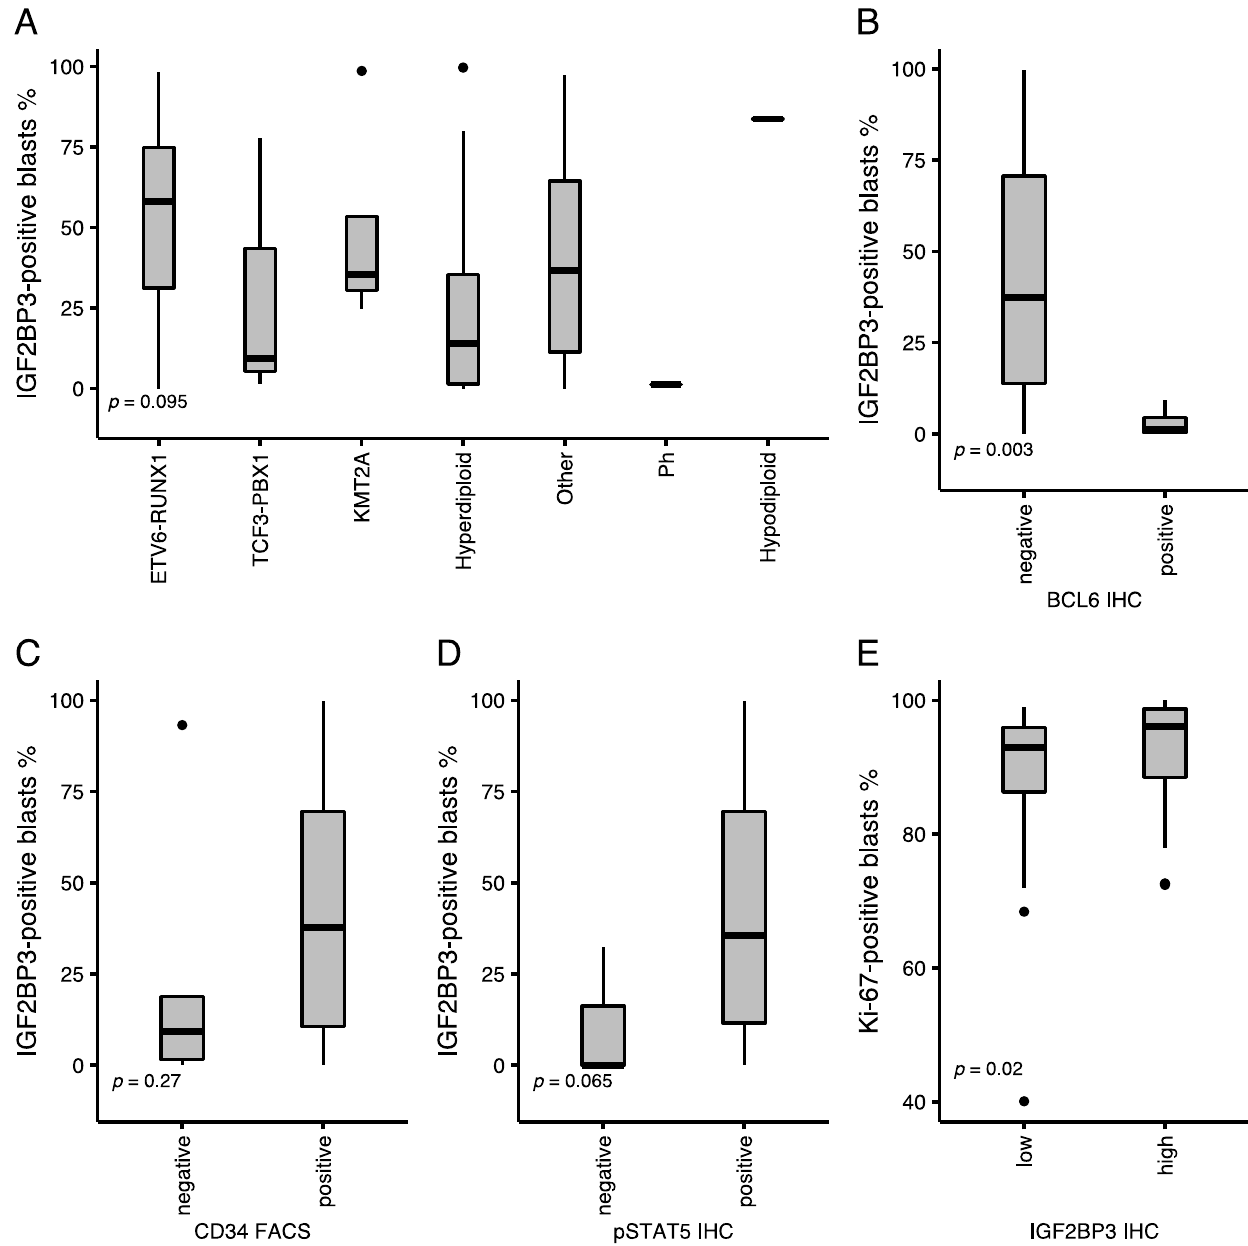
Figure 2. Immunophenotype of a B-cell acute lymphoblastic leukemia (B-ALL) tissue microarray cohort. ( A ) Expression of IGF2BP3 according to the WHO classification of B-ALL. ( B ) Positivity to IGF2BP3 among cases with either a negative or positive expression of the BCL6 protein. ( C ) Positivity to IGF2BP3 in cases with negative or positive CD34. ( D ) Positivity to IGF2BP3 in cases with a negative or positive pSTAT5 (Y694). ( E ) Expression of Ki-67 among cases with either a low or high IGF2BP3 (median as a cut-off). Dots depict outliers. p -values of ( B – E ) Mann–Whitney U test and ( A ) Kruskal–Wallis test are shown.